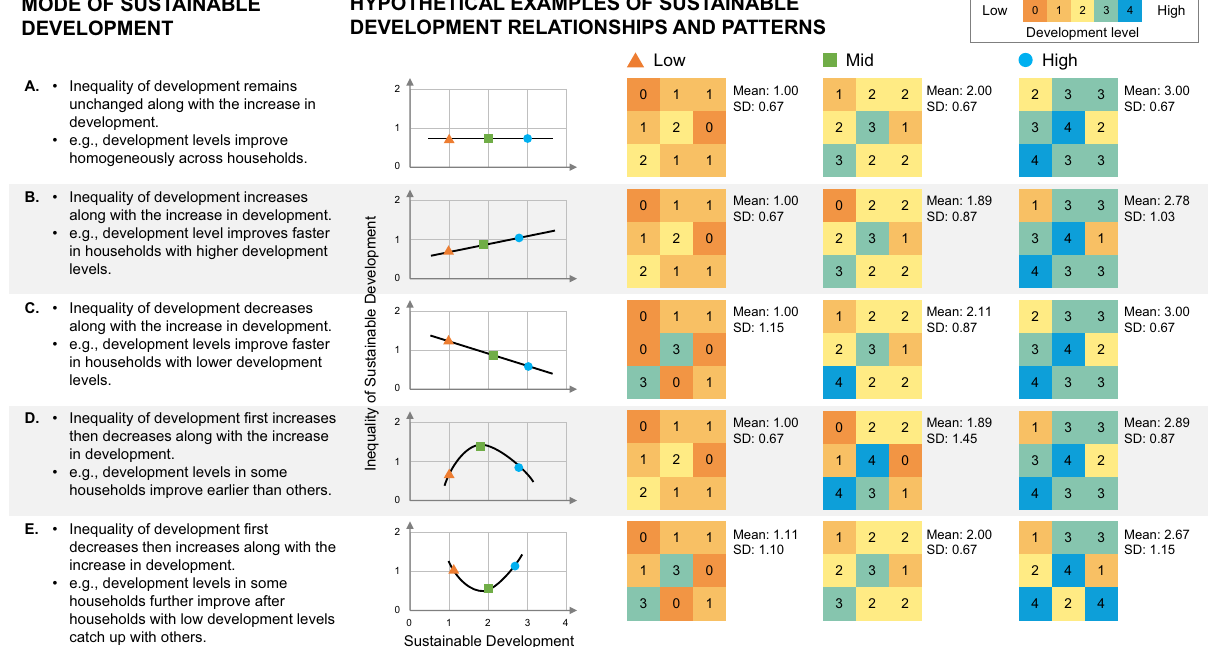
Fig. 5 Five modes of sustainable development. For each mode, example patterns of inequality at low, medium, and high levels of sustainable development are illustrated. Household water security is one aspect of sustainable